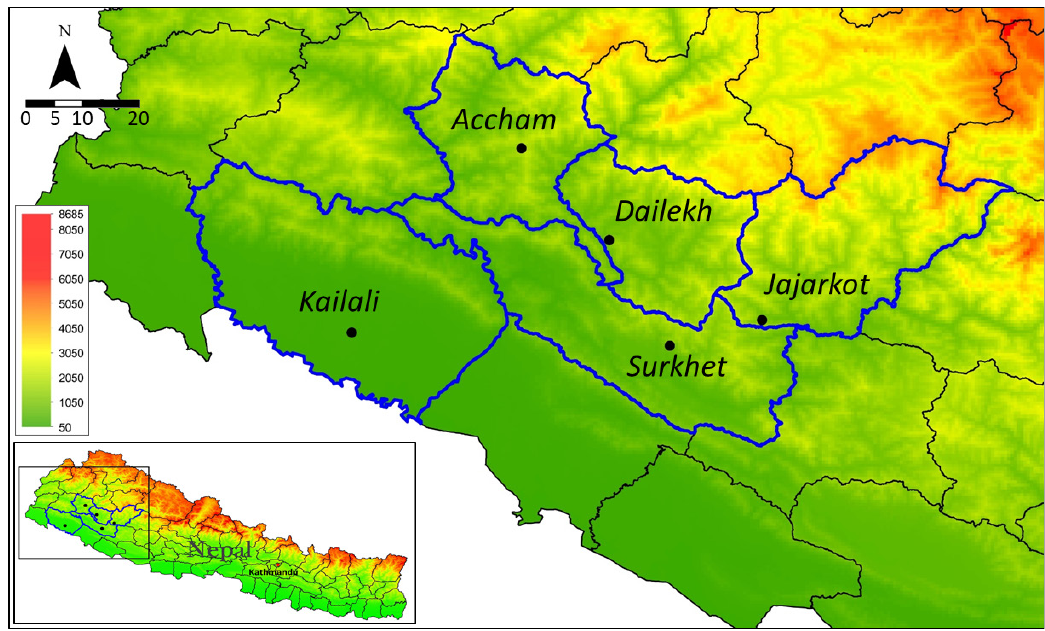
Figure 1. Location of the study area in Mid and Far-Western Nepal. Study villages are marked as black dots with district names shown.